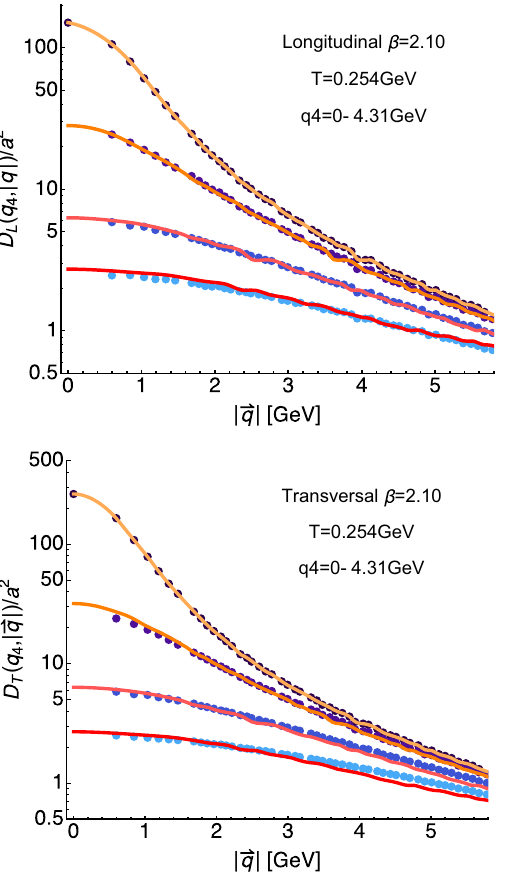
Fig. 6 The longitudinal gluon propagators for β = 2 . 10 evaluated at T = 254 MeV. (left) Shown are correlators vs. spatial momenta at the first four available imaginary frequencies q 4 = 0 − 4 . 31 GeV. The orange curve represents a naive spline interpolation ˜ D L / T ( | q | ) of D L / T ( q 4 = 0 , | q | ) . The dark orange and red curves correspond to the interpolation evaluated using the assumption of O ( 4 ) invari- + | q | 2 ) . (Right) Use of the interpolation ˜ D q 2 4